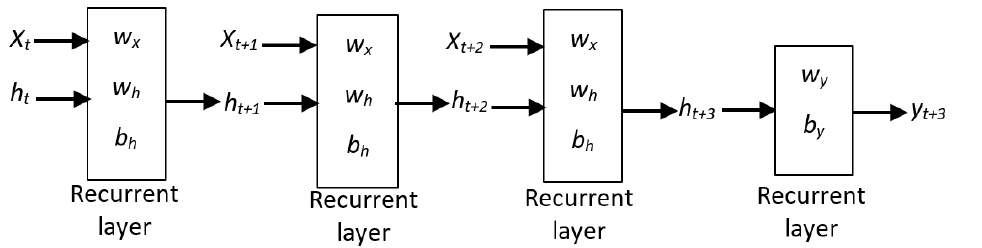
Figure 7. Compressed representation for the RNN [62].